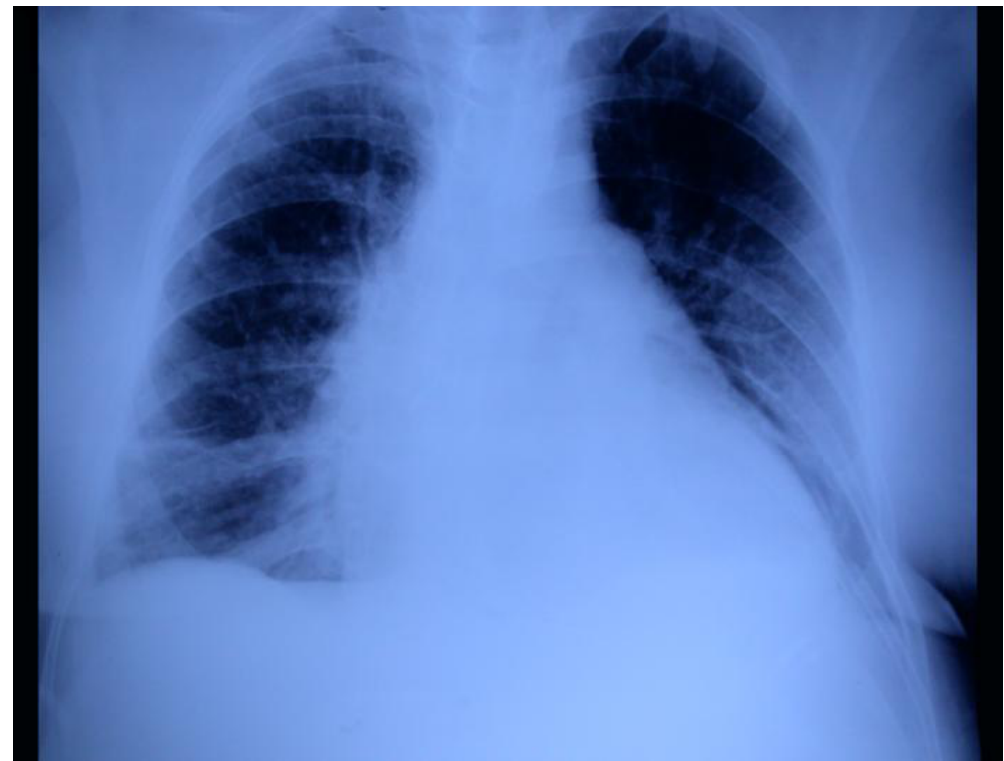
FIGURE 2. X-ray image showing diffuse bilateral alveolar infiltrates and Kerley’s striae.